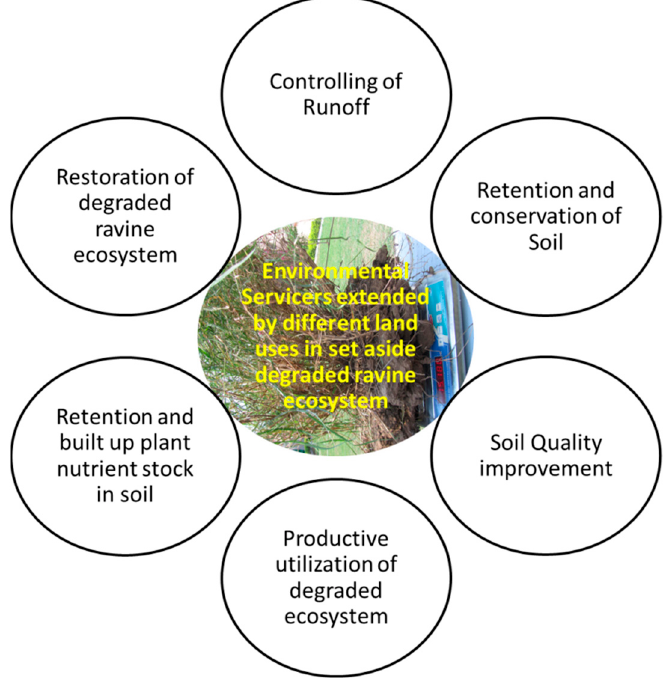
Figure 12. Environmental services generated by introducing different land use systems in degraded ecosystems.